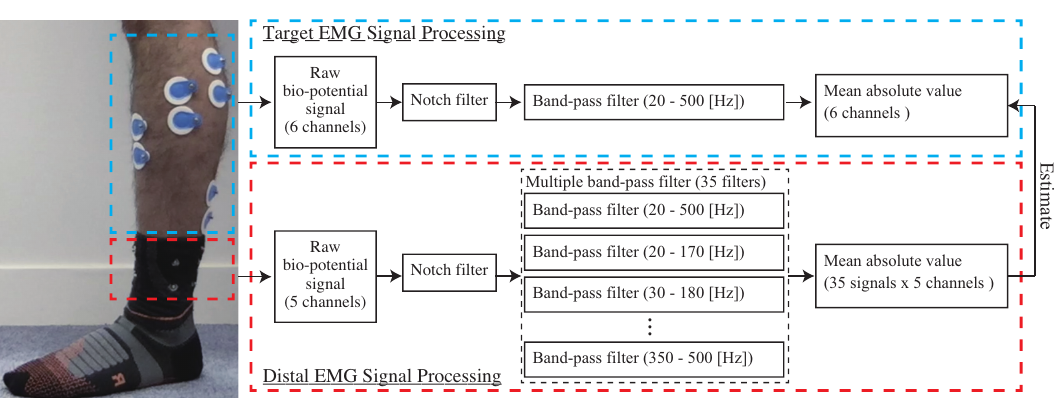
Figure 7. Diagram of EMG